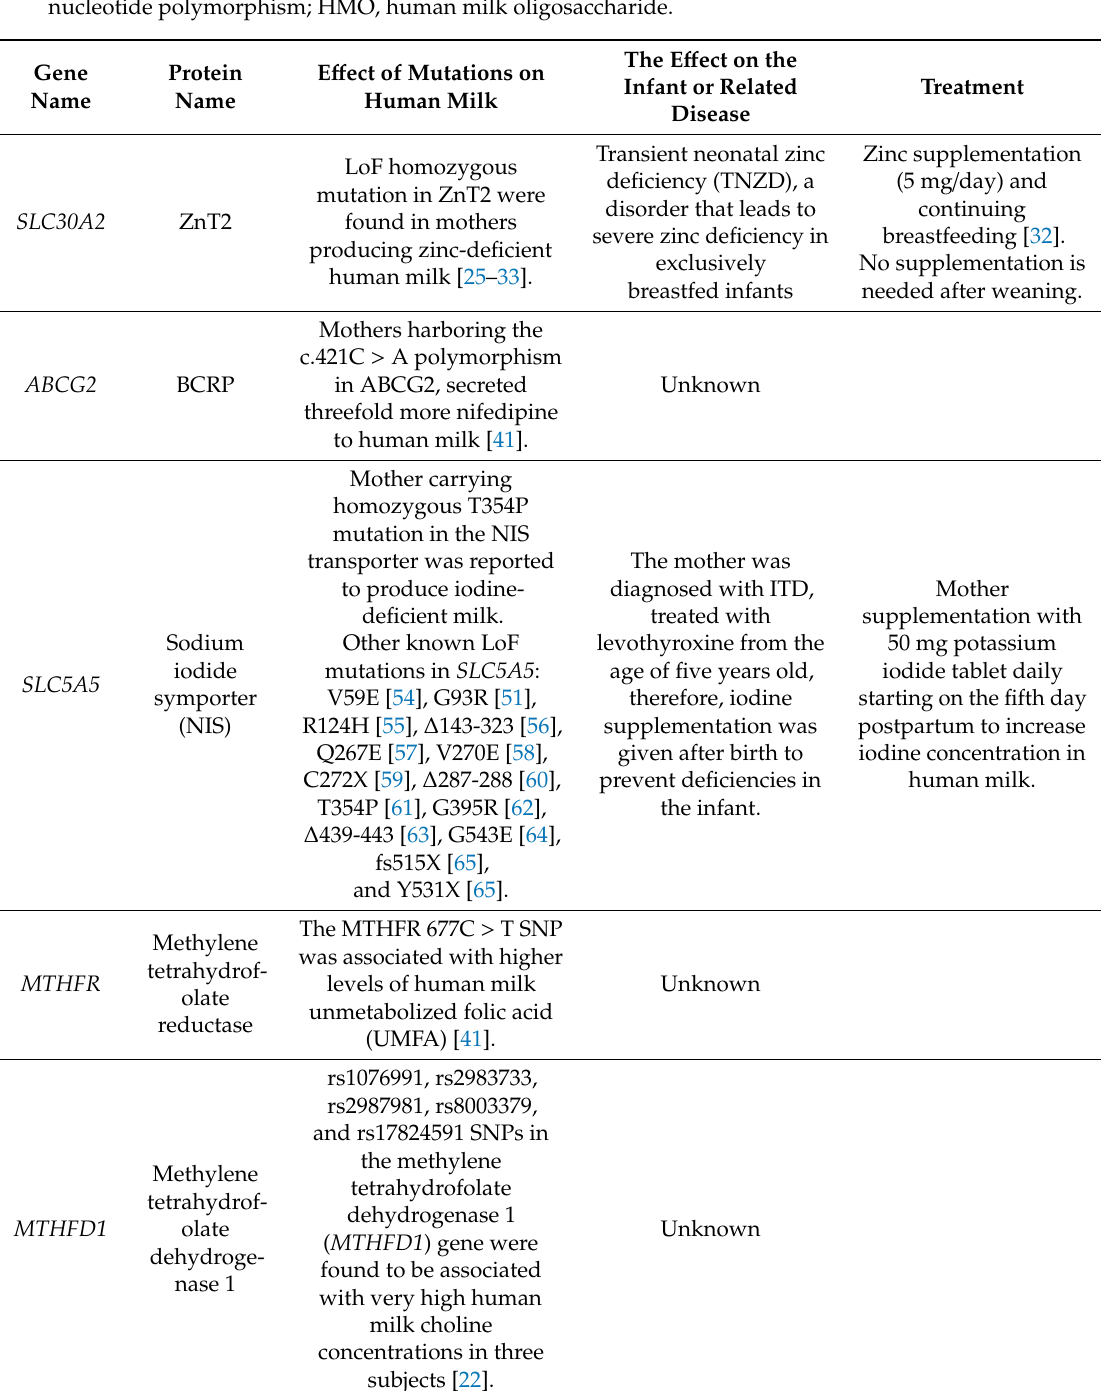
Table 1. Genetic variations that were associated with changes in human milk components, as well as the e ff ect on the infant and suggested treatment. LoF, loss of function; BCRP, breast cancer resistance protein; ABCG2, ATP-driven, multidrug e ffl ux transporter; ITD, iodide transport defect; SNP, single nucleotide polymorphism; HMO, human milk